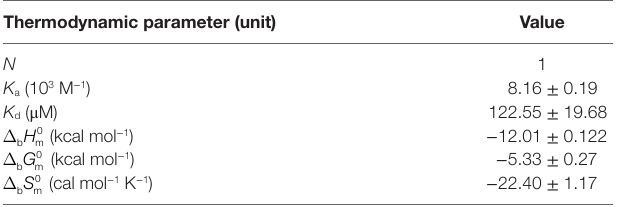
TaBle 2 | Thermodynamic parameters for the binding of rCgDM9CP-1 to d -mannose as determined by